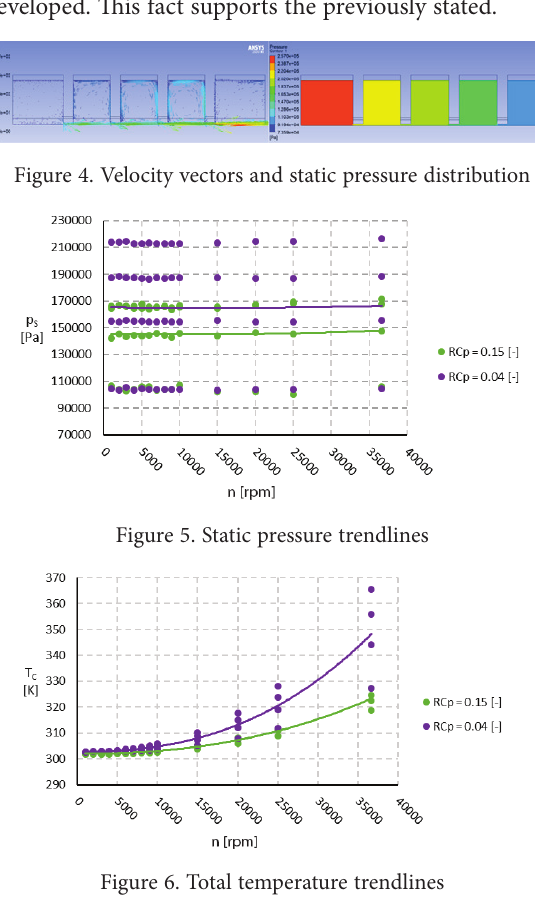
Figure 6. Total temperature trendlines